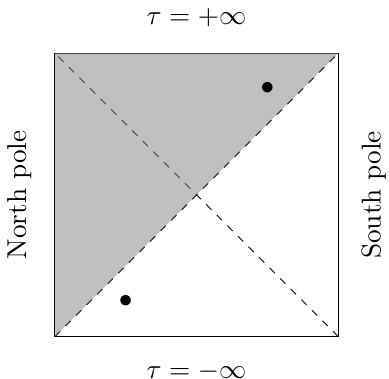
Figure 4 . Penrose diagram of de Sitter space. The shaded region is the causal future of the north pole, and its dashed 45 (cid:14) boundary is the future horizon of the south pole. The antipodal map amounts to a couple of horizontal and vertical (cid:13)ips. Especially, the north pole at far past is mapped to the south pole at far